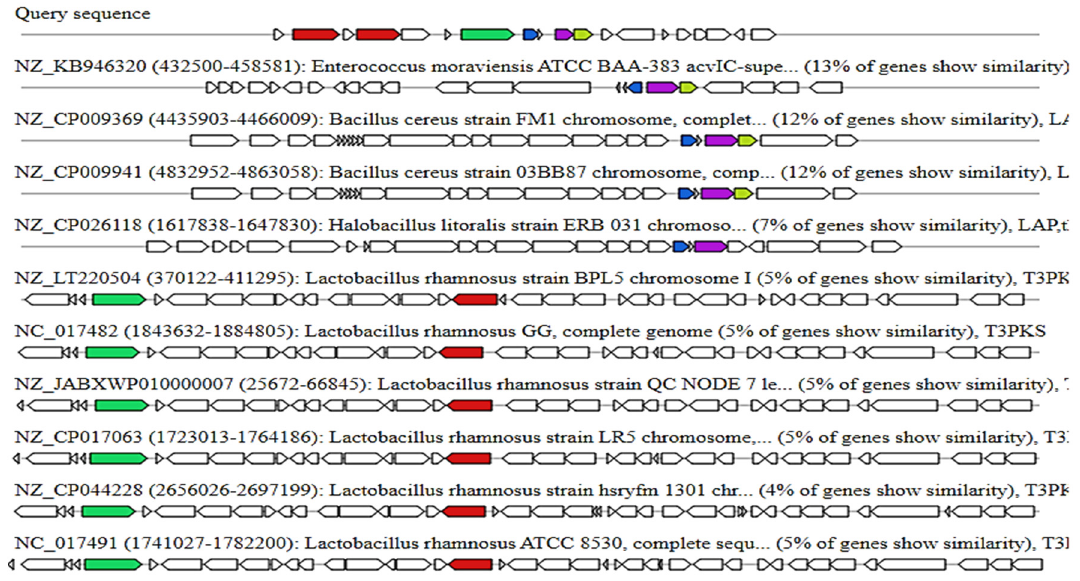
Figure 4. Shows the Lp YW11 genome’s EPS-producing sites. Core biosynthetic genes are represented by the colors red, pink, green, blue, and grey. Regulatory genes are represented by the color green (Other genes). ( A ) The autoinducer cyclic lactone ( B ) terpene ( C ) T3PKS ( D ) RiPP likes.